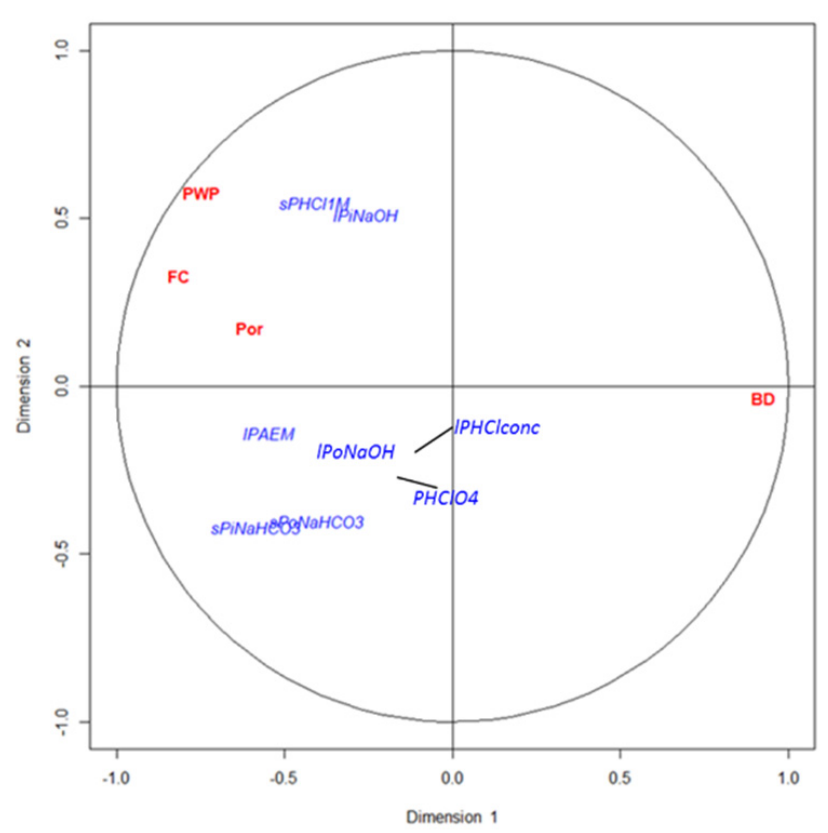
Figure 4. Variables plot for the first and second canonical dimensions of the Canonical Correlation Analysis performed to the P fractions and the physical fertility-related parameters. Abbreviations for soil parameters as in Table S2. Table 5. Spearman’s correlations between P fractions and soil physical fertility-related